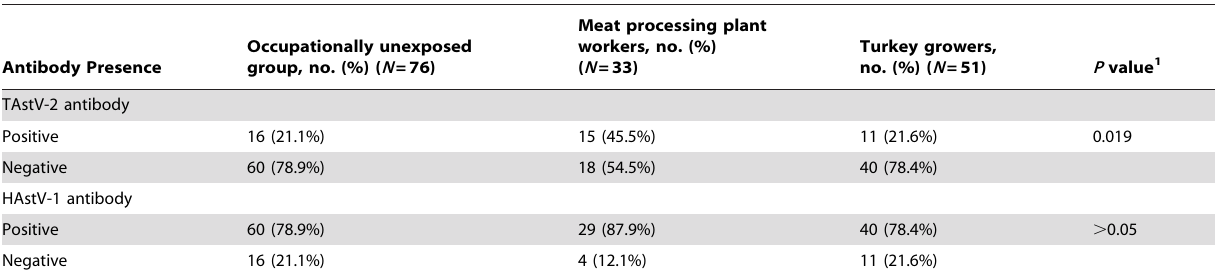
Table 2. Serologic and demographic results of Cohort C.